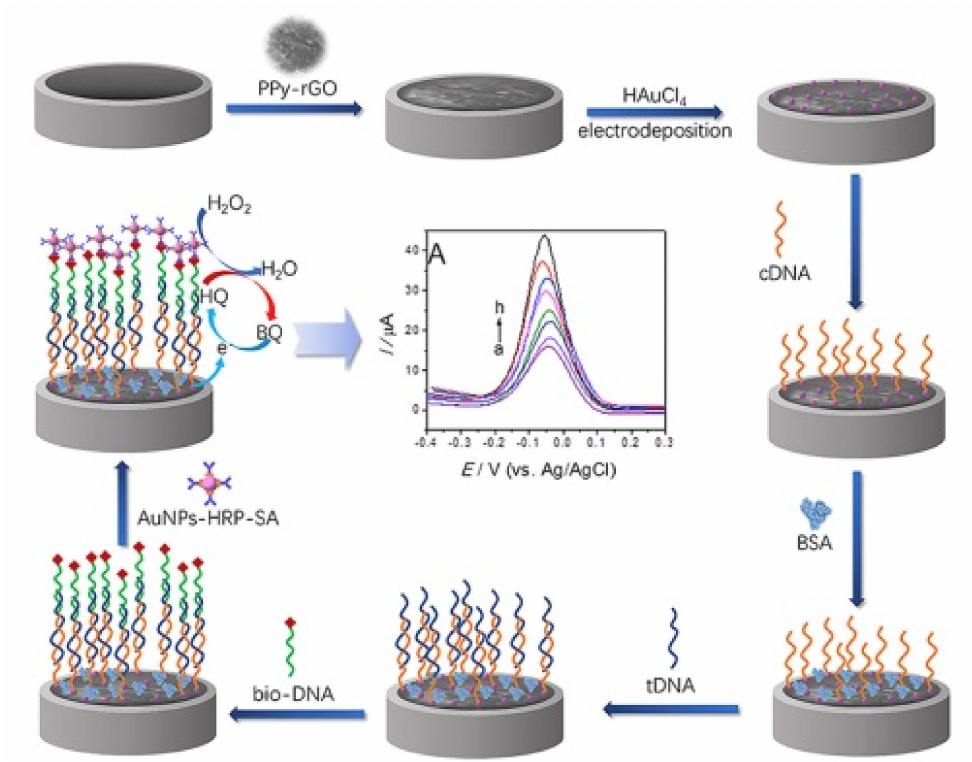
Figure 7. Scheme of the strategy for the electrochemical detection of the Salmonella inv A gene. Adapted with permission from [102] Copyright 2019,